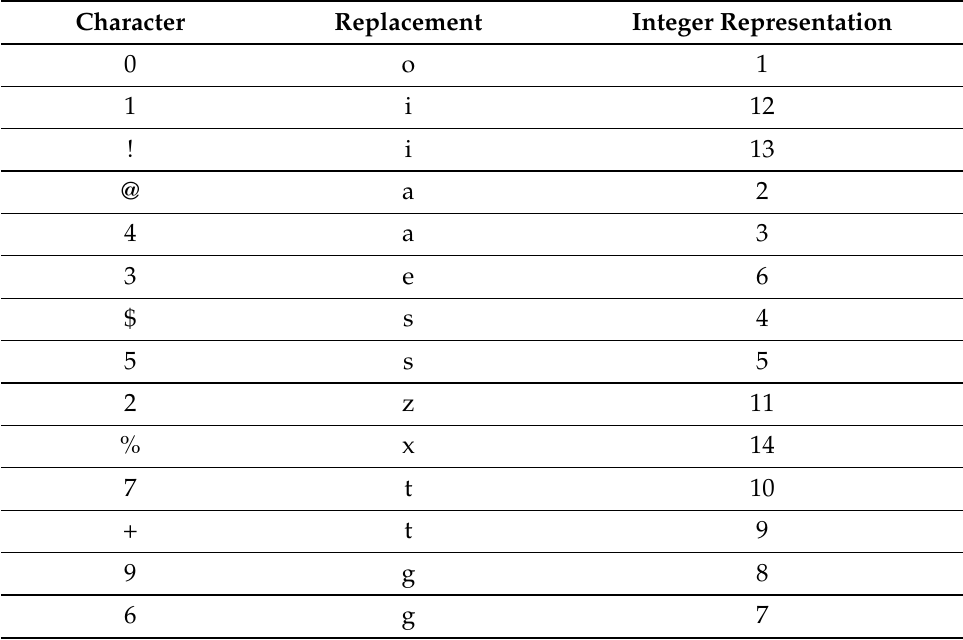
Table 1. Correspondence for a l33t